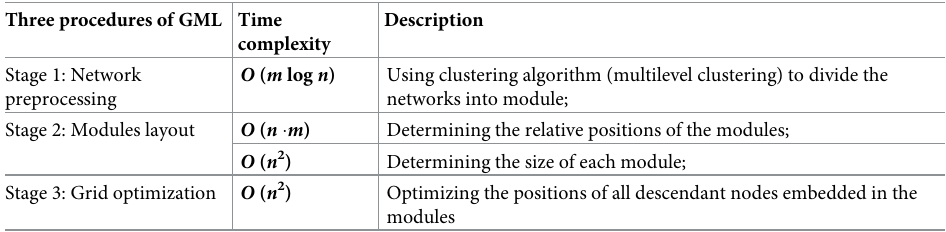
Table 2. Time complexity of GML (for a network of n nodes and m